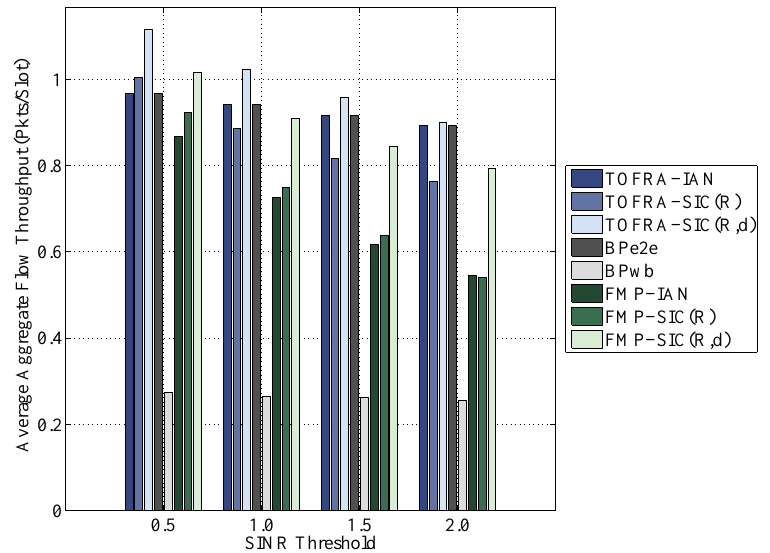
Figure 4. Topology 2: AAT per flow allocation